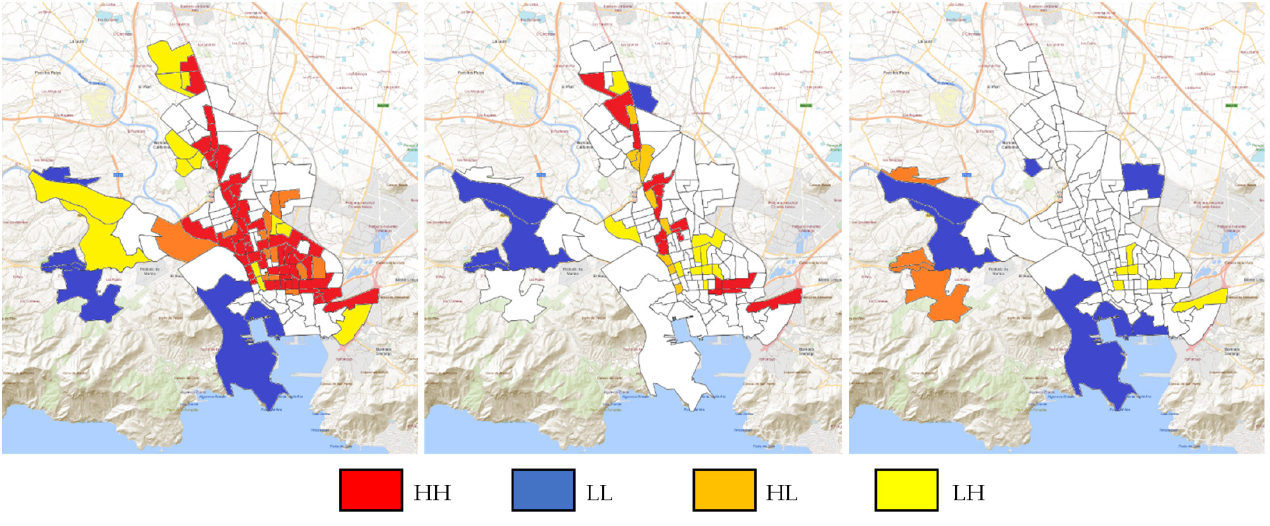
Figure 14. Current trend of LISA hot spots maps between mobility indicators and AQI for March and April 2021 (case order: PVUD ‐ EAQI/IPTU ‐ EAQI/HMD ‐ EAQI).